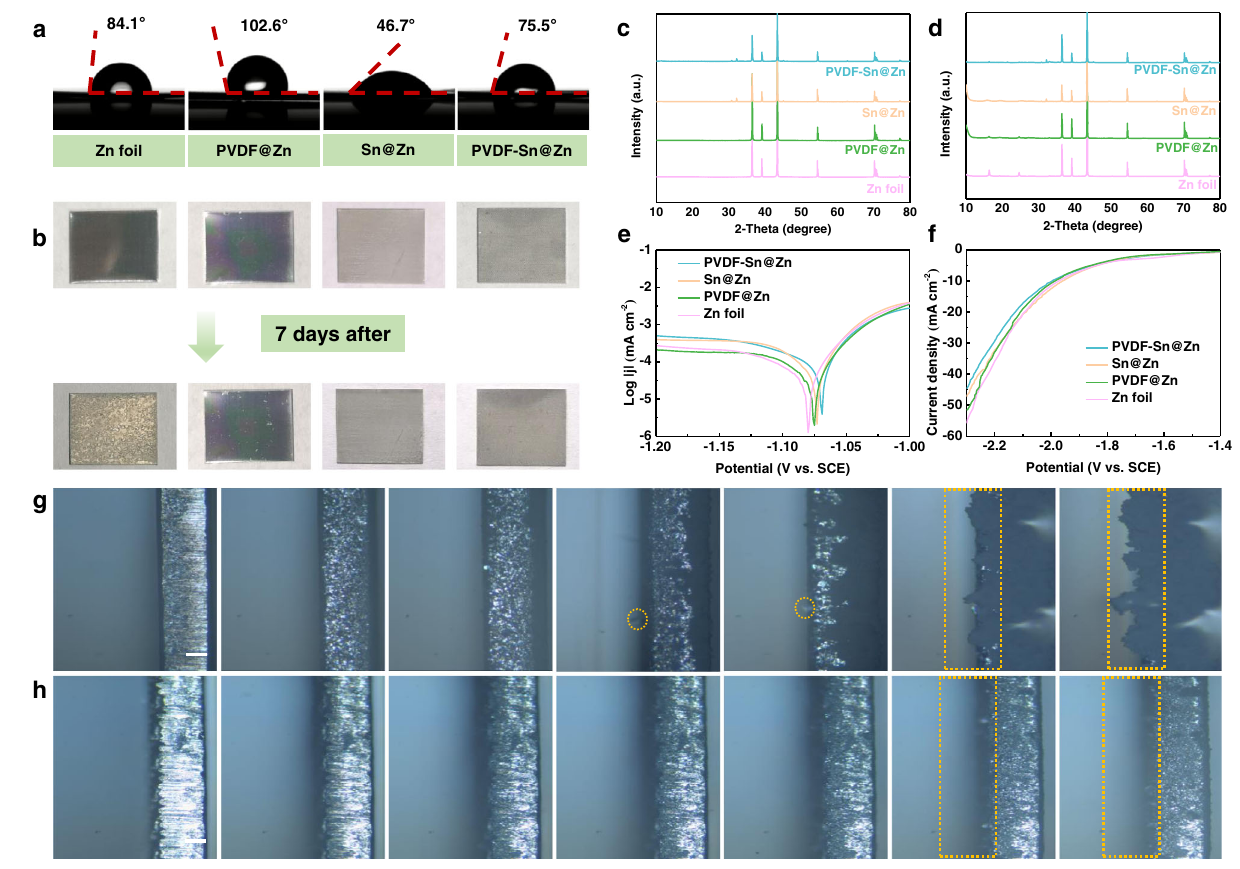
Fig. 3 | Side reaction resistance of PVDF-Sn@Zn gradient electrode. a Contact angles of 2M ZnSO 4 aqueous solution on the different electrodes. b Digitalphotos of different electrodes in the initial state and after immersion in 2M ZnSO 4 elec- trolyte for 7 days. XRD patterns of different electrodes c before and d after